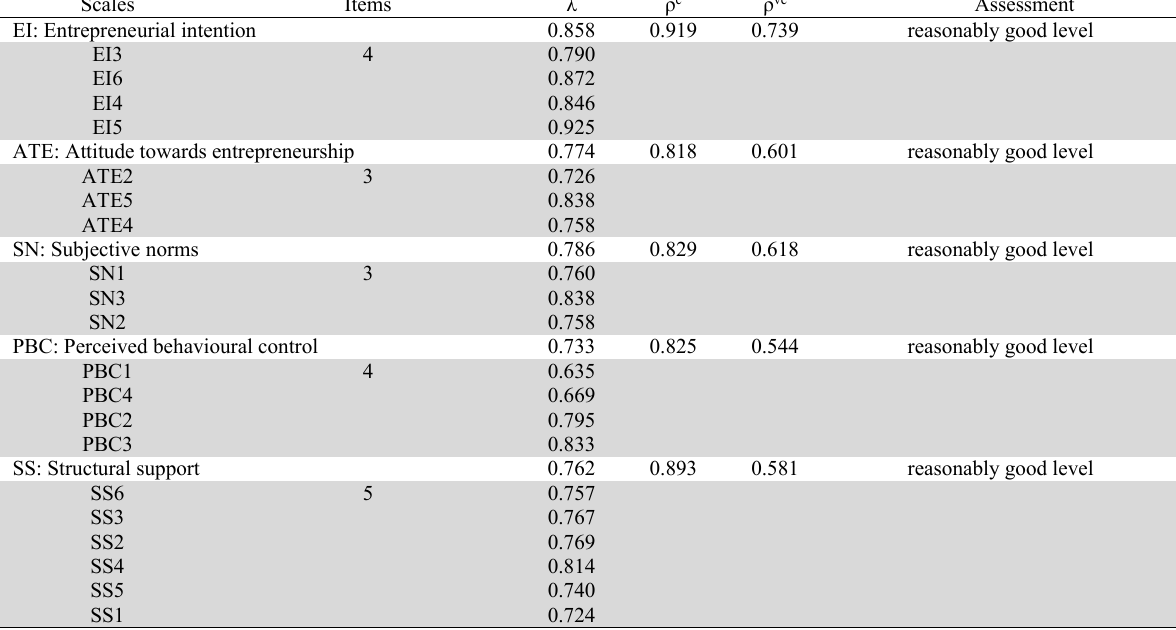
The results of testing the measurement validity by confirmatory factor analysis Scales